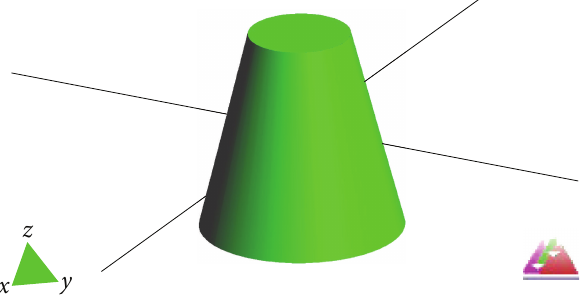
Figure 5: Truncated cone description: size (in mm). The height of the target is 200mm. The major diameter is 200 mm and the minor one is 100 mm. Table 1: Information of the simulation